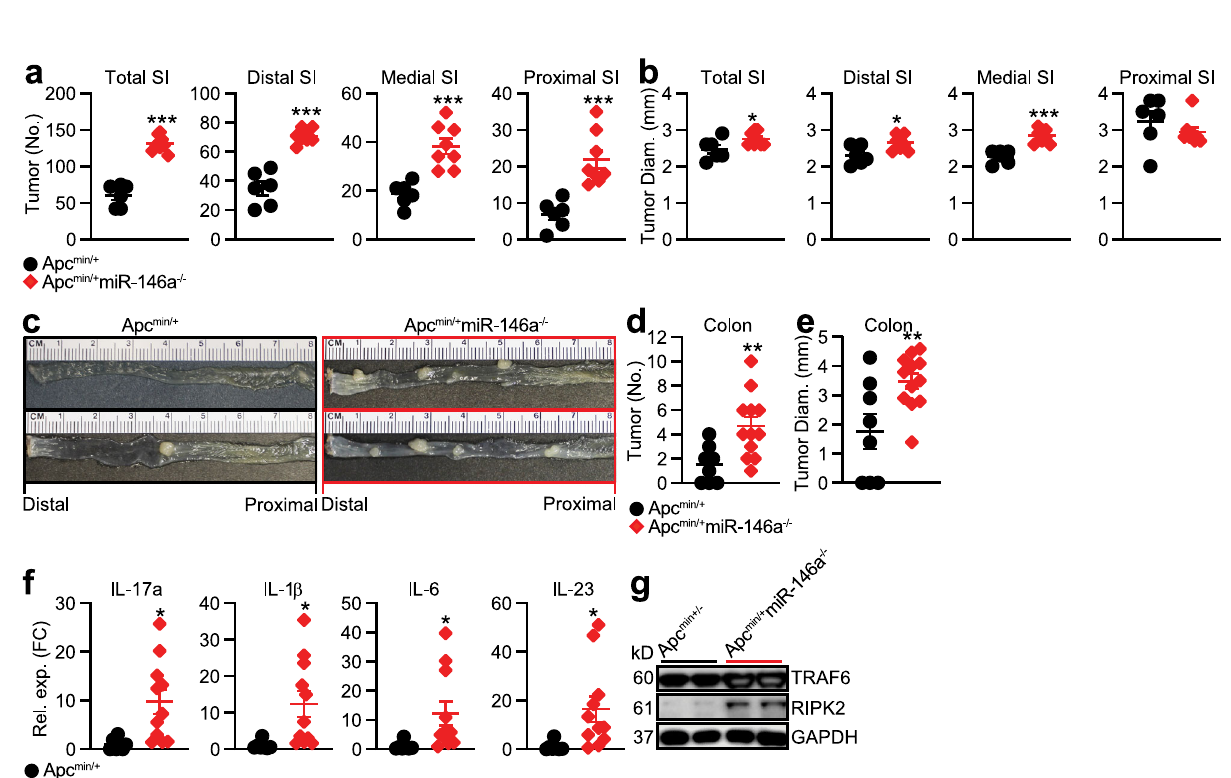
Fig. 4 IEC-speci fi c deletion of miR-146a promotes CRC development. a – c Representative images ( a ), numbers ( b ), and sizes ( c ) of colonic tumors in miR- 146a fl / fl and IEC-miR-146a − / − (Villin Cre MiR-146a fl / fl ) mice with AOM/DSS-induced CRC ( n = 8). d Western blottings of TRAF6, NF- κ B subunit phospho- p65 (pp65), and phospho-p38 (pp38) MAPK in CRC tissue from these mice. e In silico target prediction of miR-146a binding the TRAF6 3 ′ -UTR. f Luciferase activity in IEC line (CMT-93) transfected with luciferase construct containing TRAF6 sequence with ctrl or miR-146a mimic ( n = 3). g qPCR of TRAF6 from streptavidin pulldown of biotinylated ctrl or miR-146a mimic-transfected CMT-93 IECs ( n = 3). h Representative FACS histograms and MFIs of TRAF6 in FACS-sorted IECs from miR-146a fl / fl and IEC-miR-146a − / − mice with AOM/DSS-induced CRC. MFI as FC from miR-146a fl / fl ( n = 5). i Western blottings of TRAF6, pp65, and pp38 in IECs from these CRC mice. j Western blottings of these molecules in miR-146a-suf fi cient (WT) and miR- 146a-de fi cient (miR-146a − / − ) CMT-93 IECs stimulated with IL-17 (25 ng/ml) for 1.5 h. k , l Western blottings of Cox-2 and β -catenin in CRC tissue ( k ) and IECs ( l ) from CRC miR-146a fl / fl and IEC-miR-146a − / − mice. m Western blottings of Cox-2 and β -catenin in WT and miR-146a − / − CMT-93 IECs stimulated with IL-17a (25 ng/ml). n ELISA of PGE2 in WT and miR-146a − / − CMT-93 IECs stimulated with IL-17a (25 ng/ml) for 48 h ( n = 6). o , p qPCR of PTGES2 in CRC tissue ( o ) and IECs ( p ) from CRC miR-146a fl / fl and IEC-miR-146a − / − mice. qPCR data as FC from miR-146a fl / fl ( n = 8). q , r Western blotting of PTGES2 in CRC tissue ( q ) and IECs ( r ) from CRC miR-146a fl / fl and IEC-miR-146a − / − mice. s Western blotting of PTGES2 in WT and miR-146a − / − CMT- 93 IECs stimulated with IL-17a (25 ng/ml). t In silico target prediction of miR-146a binding the PTGES2 3 ′ -UTR. u Luciferase activity in CMT-93 IECs transfected with luciferase construct containing PTGES2 sequence with ctrl or miR-146a mimic ( n = 4). v qPCR of PTGES2 from streptavidin pulldown of biotinylated ctrl or miR-146a mimic-transfected CMT-93 IECS ( n = 3). w Representative colonic histopathology (scale bar = 100 µ m) with Ki67 staining in WT and miR-146a − / − mice with AOM/DSS-induced CRC. x , y Representative images ( x ) and numbers ( y ) of colonic tumors in miR-146a fl / fl and IEC-miR- 146a − / − mice treated with anti-IL-17a (500 μ g/ml) twice a week throughout AOM/DSS CRC induction ( n = 5). z Model depicting IEC-intrinsic miR-146a in limiting tumorigenic IL-17 signaling in IECs. Data are representative of ≥ 2 independent experiments. n = biologically independent replicates per group ( b , c , h , o , p , y ) or replicates pooled from independent experiments ( f , g , n , u , v ). Mean ± SEM. * p < 0.05, ** p < 0.01, *** p < 0.001, by two-way ANOVA with